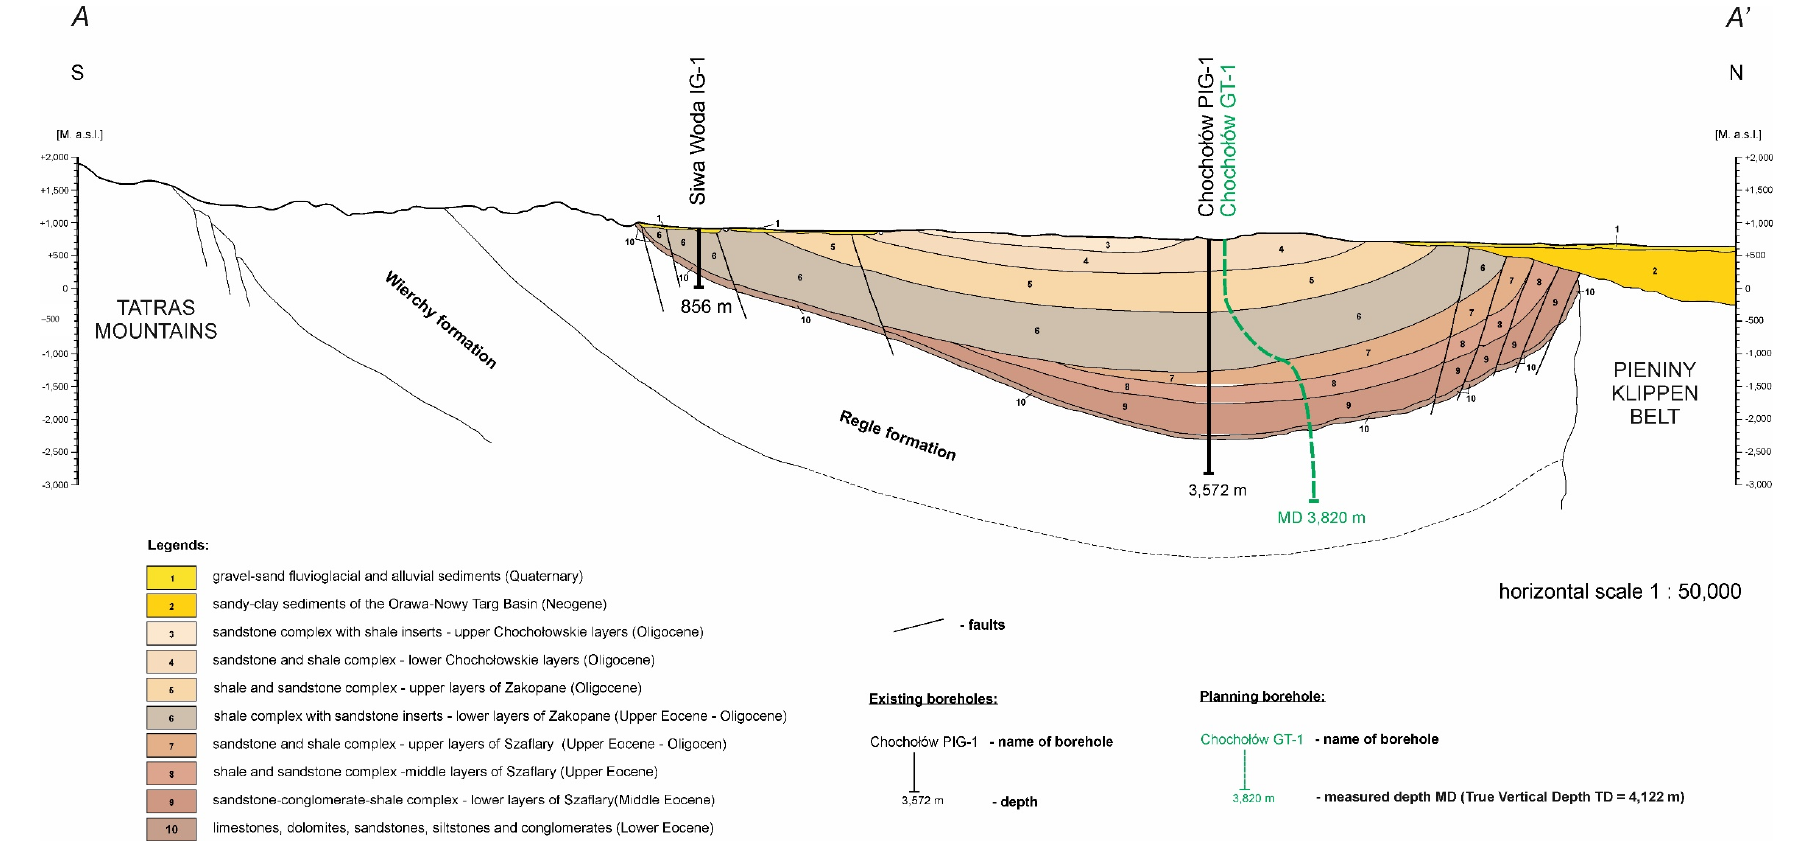
Figure 2. Geological cross-section [30], modified to show the projected borehole.